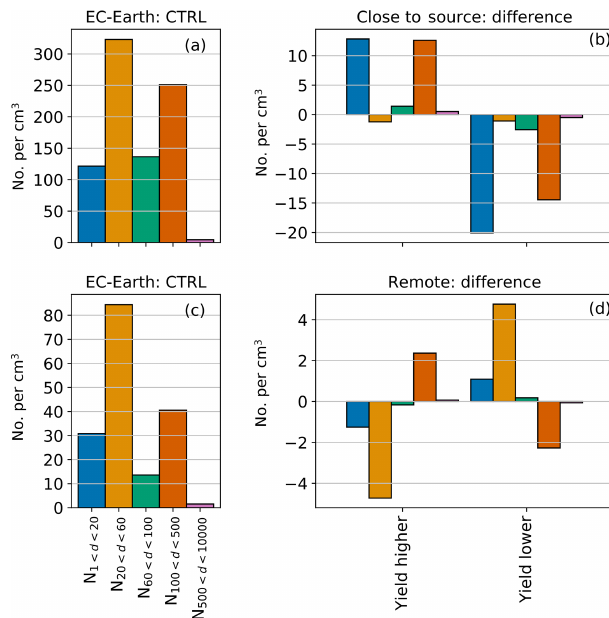
Figure 9. Bar plots of the number concentration of particles of se- lected sizes ranges for EC-Earth, close to and far away from the sources. In panels (a) and (c) the number concentrations from the CTRL simulations are shown. In panels (b) and (d) the differences between the sensitivity simulations and the CTRL simulations are shown for each size bin. Note that there are different scales used for the different regions. The areas defined as close and remote are based on changes in CCN concentrations (positive or negative) at 1% supersaturation. These areas can be seen in Fig. S21.